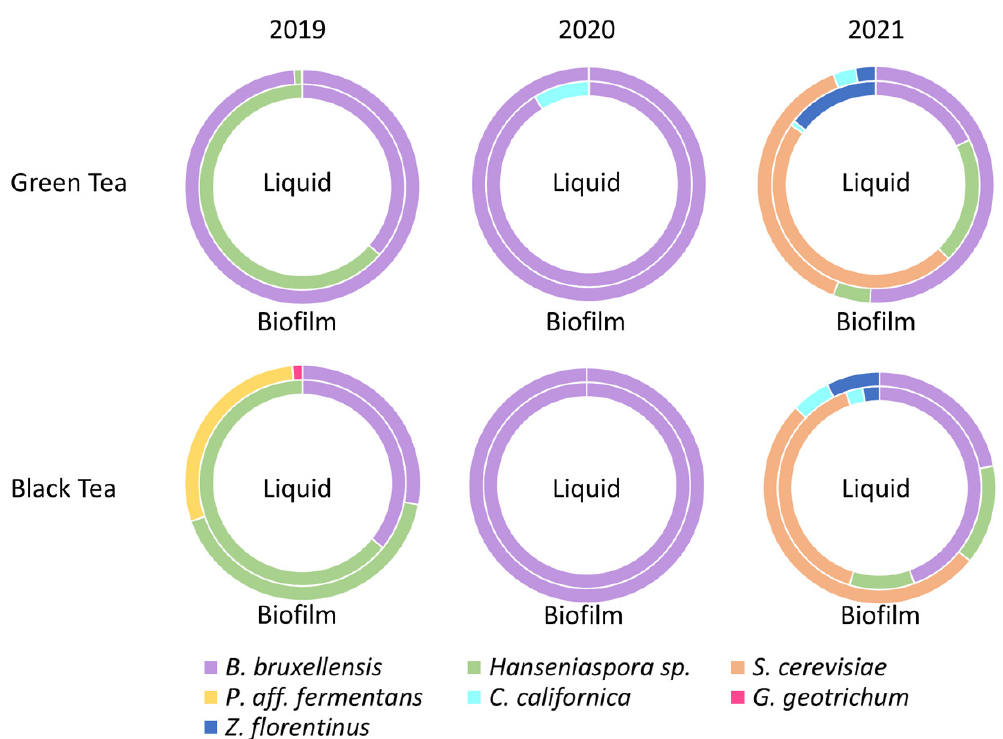
Figure 3. Proportions in yeasts species in green and black tea kombuchas liquid and biofilms samples over 3 years. Internal circles refer to the liquid phase and external circles to biofilm.